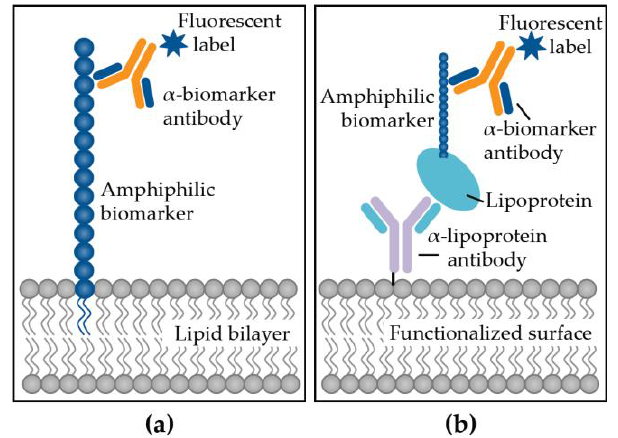
Figure 2. Immunoassay strategies to detect lipid and amphiphilic biomarkers using ( a ) membrane insertion or ( b ) lipoprotein capture.